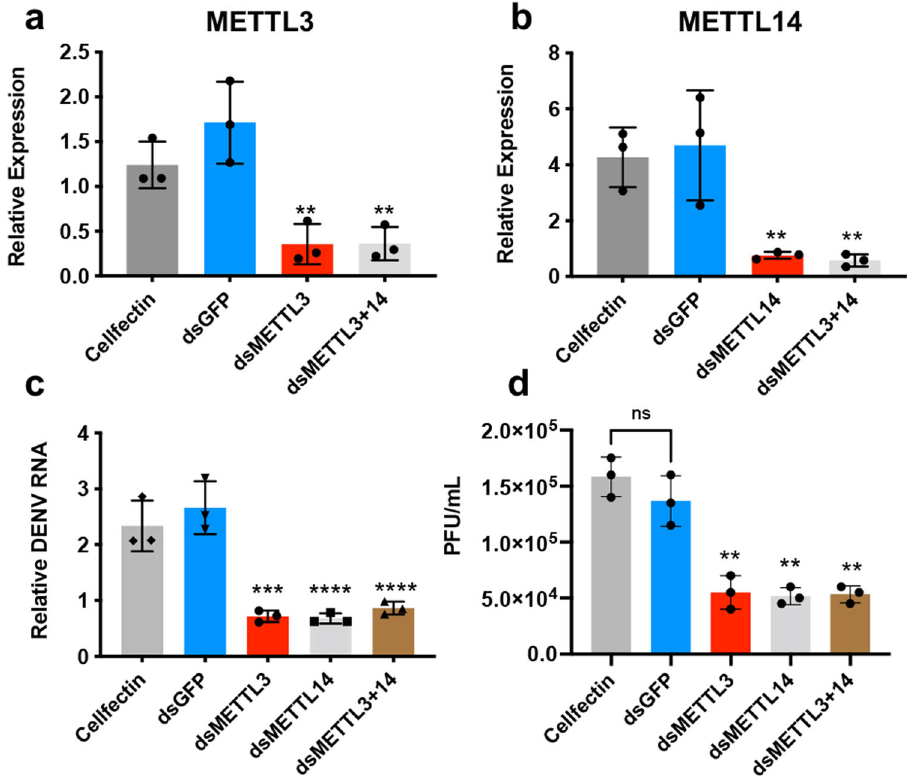
Fig. 5 Silencing m 6 A methyltransferase genes reduces DENV replication. Expression levels of a METTL3 and b METTL14 in Aag2 cells transfected with dsRNA to METTL3 (dsMETTL3), and double transfection with dsRNAs to METTL3 and METTL14 . dsRNA to GFP (dsGFP) was used as negative control in addition to the Cellfectin transfection reagent only. c , d Reductions in DENV replication in Aag2 cells by silencing METTL3 / METTL14 or both. Cells were collected at 72hpi for RNA extraction and quanti fi cation of DENV RNA by RT-qPCR ( c ), and the supernatants were harvested for quanti fi cation of DENV virions by plaque assay ( d ). Error bars represent mean ±S.D. ns, not signi fi cant, ** p <0.01; *** p <0.001; **** p <0.0001. ANOVA test with post hoc comparisons.